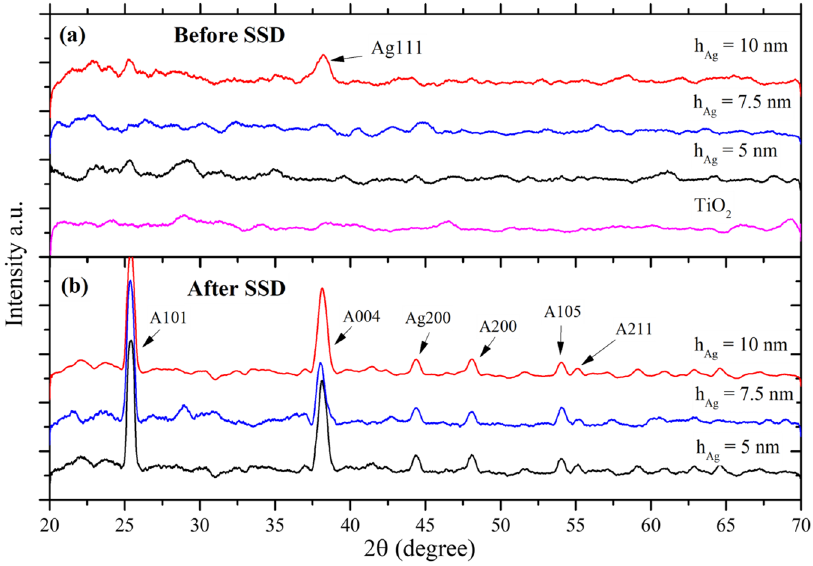
Figure 4. XRD of ( a ) Ag/TiO 2 structures (before SSD) and ( b ) AgNP/TiO 2 structures (after SSD).